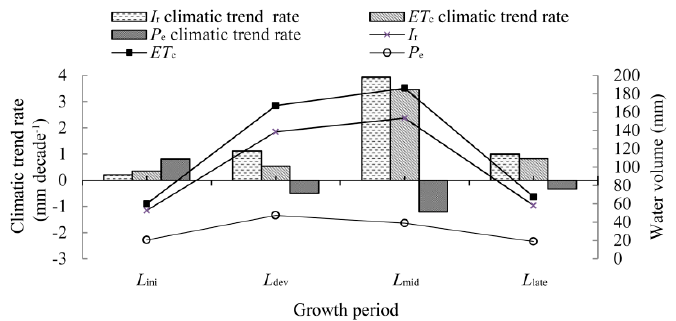
Figure 9. Change in P e , ET c , and I r at different growth stages in maize areas of Inner Mongolia from 1959 to 2019 and the climatic trends of each.